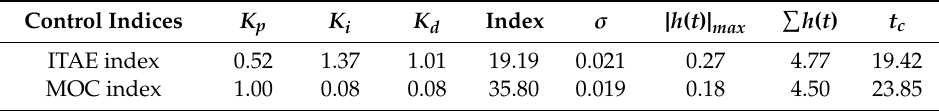
Table 1. Comparison of PID parameters and performance